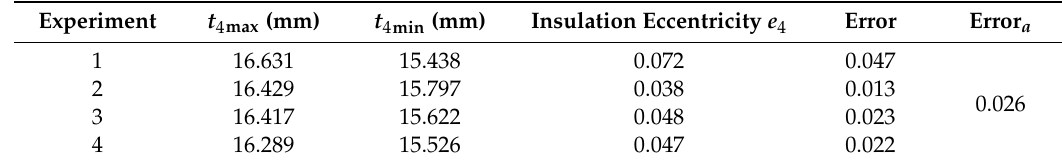
Table 7. Measurement errors of insulation eccentricity in four experiments. Experiment